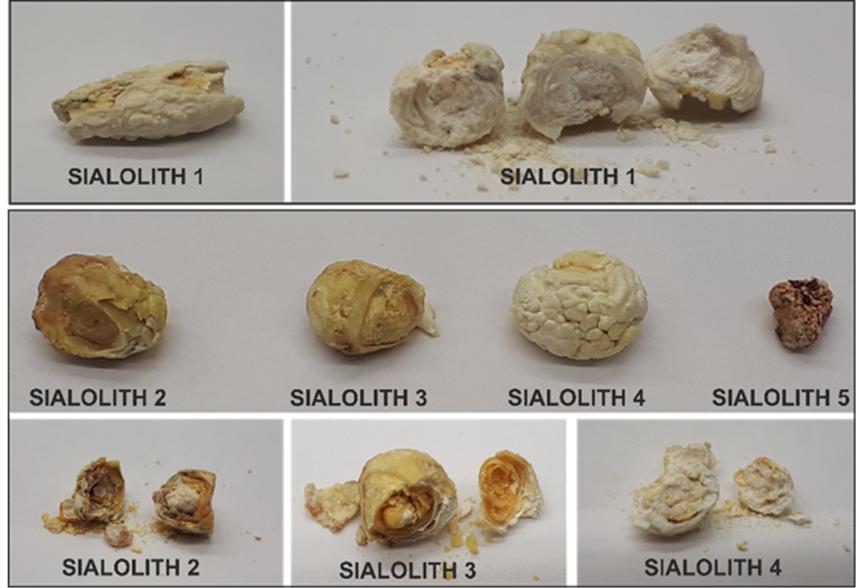
Figure 1. Pictures of sialoliths used for qualitative and quantitative